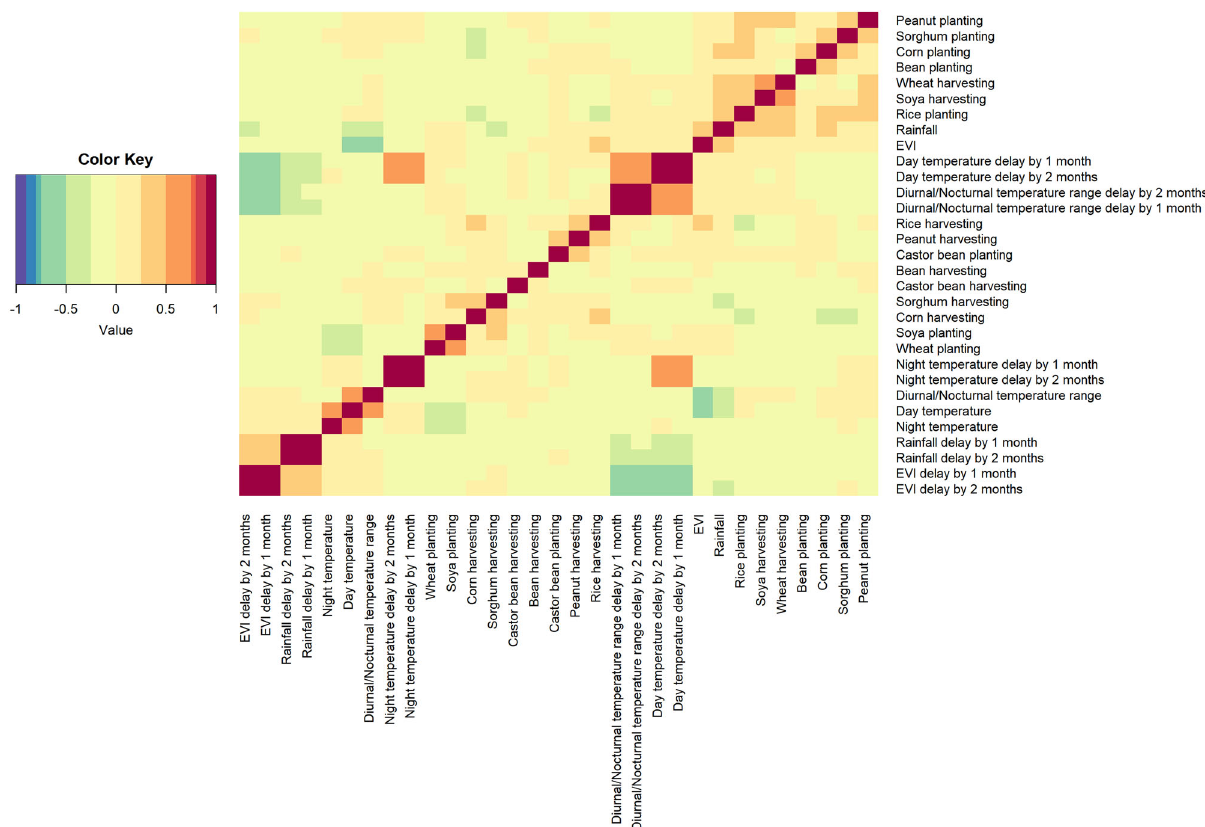
Fig. 6 Heatmap of the correlation ( − 1 to 1) of agriculture seasonality and climate covariates included in the